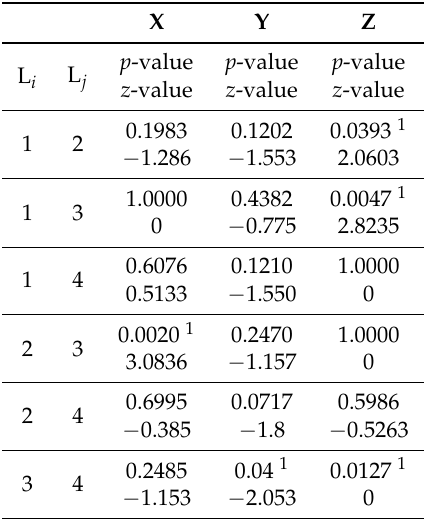
Table 6. Stochastic values for added mass in the free decay test.